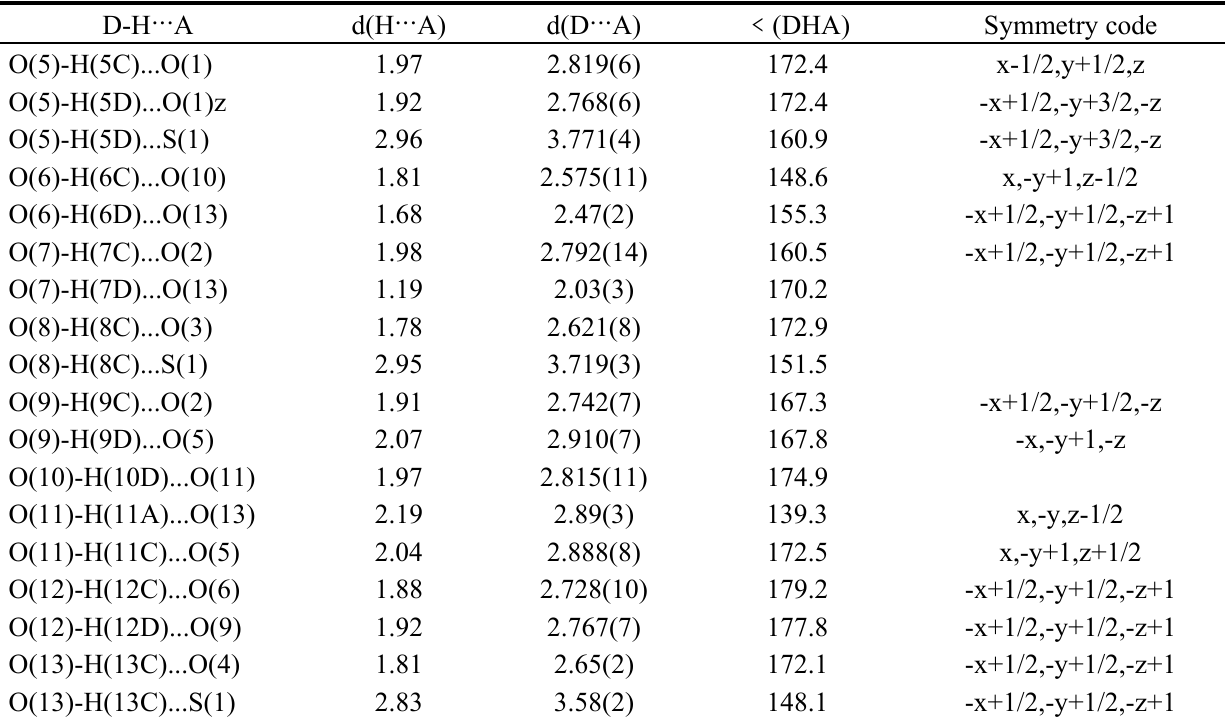
Table 2. H-bonded lengths (Å) and angles ( ˚ ) of complexes 1 and 2